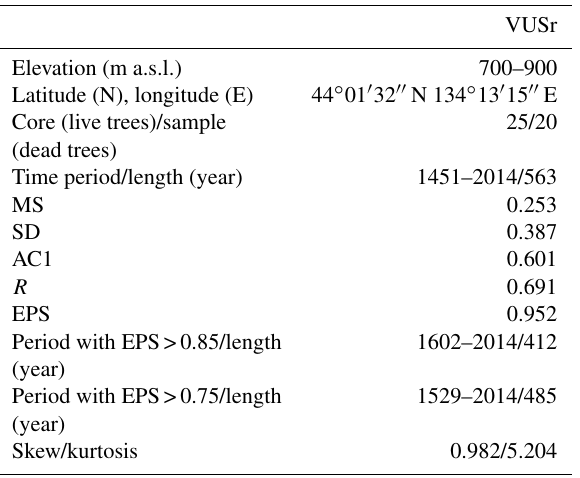
Table 1. The sampling information and statistics of the signal-free